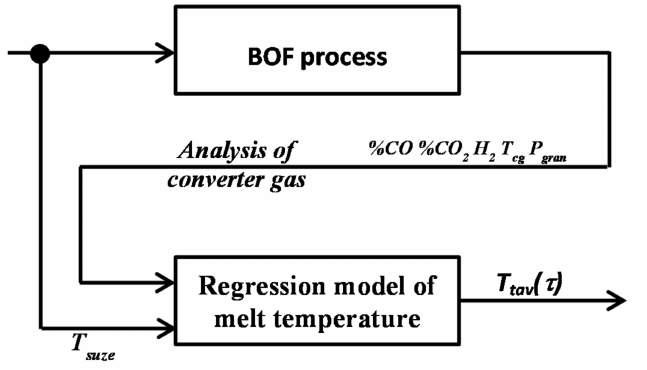
Figure 2. Scheme of the regression